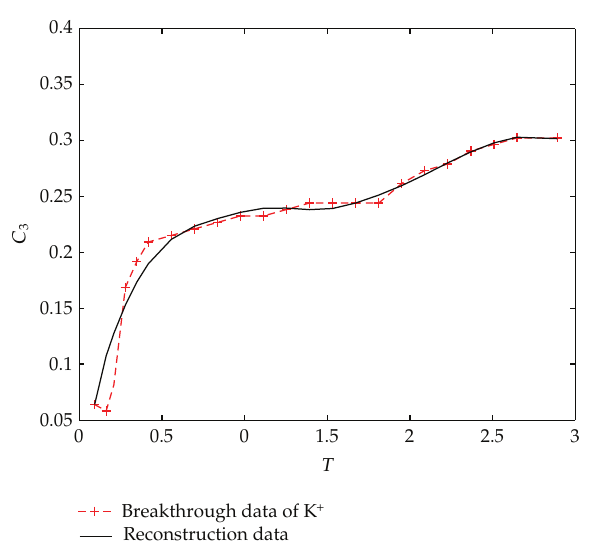
Figure 5: The breakthrough data and reconstruction data for K (cid:2)